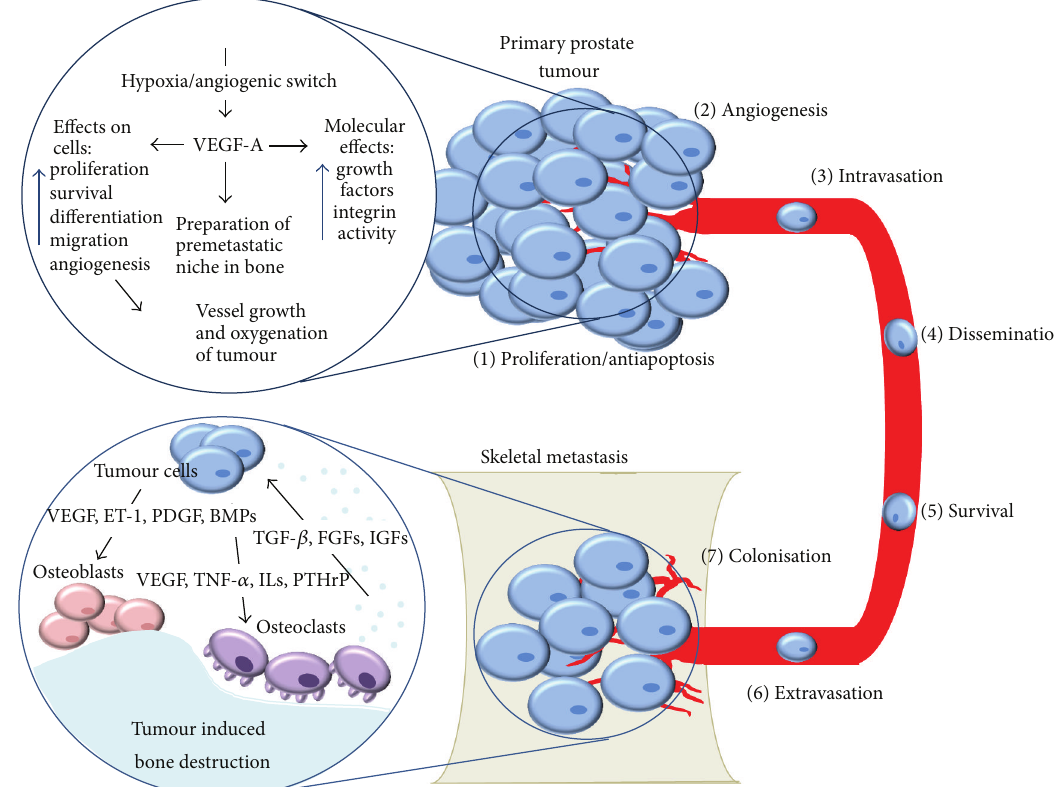
Figure 2: Tumour induced bone destruction. In the prostate, an angiogenic switch promotes the secretion of VEGF, leading to various effects on cells, increasing the release of growth factors and activating integrin activity. (1) Proliferation/antiapoptosis: the cells undergo a transformation that increases the proliferation, survival, differentiation, and migration of the tumour cells. (2) Angiogenesis: the actions of VEGF activate angiogenesis—allowing the tumour cells to access nutrients. (3) Intravasation: cells invade into the local stroma and then enter the local vasculature. (4) Dissemination: cancer cells travel to distant target organs. (5) Survival: Cells can undergo apoptosis or stop proliferation after dissemination and need to evade local immune surveillance. (6) Extravasation: invasion of target organ. (7) Colonisation: after surviving dissemination and extravasation of the target site, tumour cells invade the bone and undergo progressive growth. In metastatic bone disease, tumour cells secrete humoral factors that stimulate osteoclastic and osteoblastic recruitment and differentiation. Once these osteoclasts begin to break down bone, growth factors are released, stimulating growth of the tumour cells. This encourages the tumour cells to release factors that further increase bone resorption by osteoclast and stimulate bone formation through the activation of